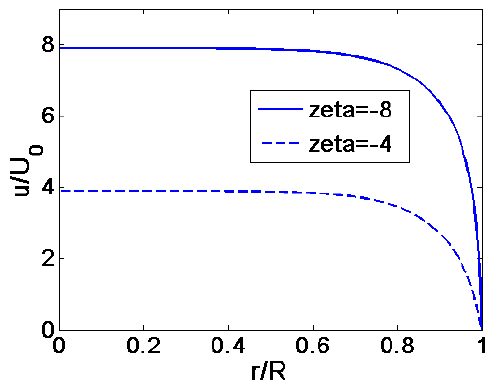
Figure 3. The comparison of the velocity profiles for different zeta potential ( n = 1, K = 10), where the reference velocity is defined as U 0 = ( εε 0 / µ 0 ) · E · ( k b T / e ).